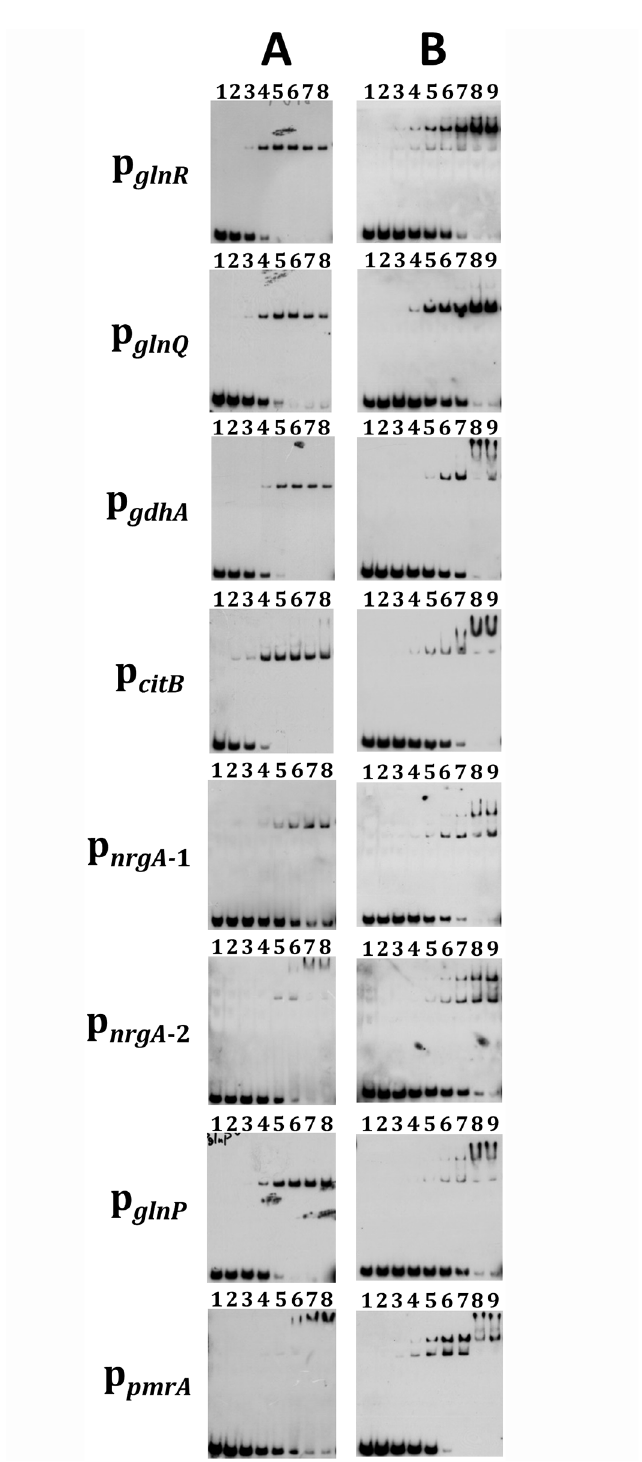
Fig 3. EMSA demonstrating the interaction of GlnR and PmrA to the promoters of genes in the GlnR regulon. The p glnR - , p glnQ - , p gdhA - , p citB - , p nrgA -1 - , p nrgA -2 - , p glnP - and p pmrA - specific DNA probes were mixed with various amounts of protein extracts. All reactions were performed with 0.025 pmol of biotin-labeled probes. (A) Lane 1, probe only. Lanes 2 to 7, use of 8 to 256 nM of MBP-GlnR in the reactions in twofold increments, respectively. Lane 8, use of 256 nM of MBP-GlnR with a non-specific competitor. In the reactions